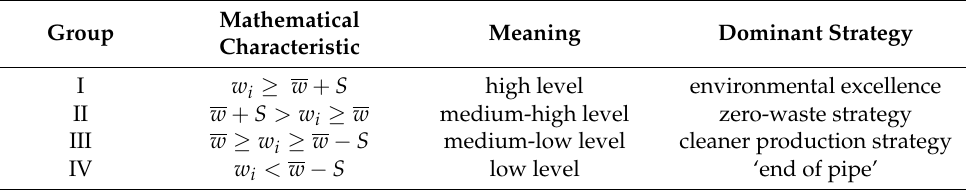
Table 2. Sustainability strategies aggregate measures comparative